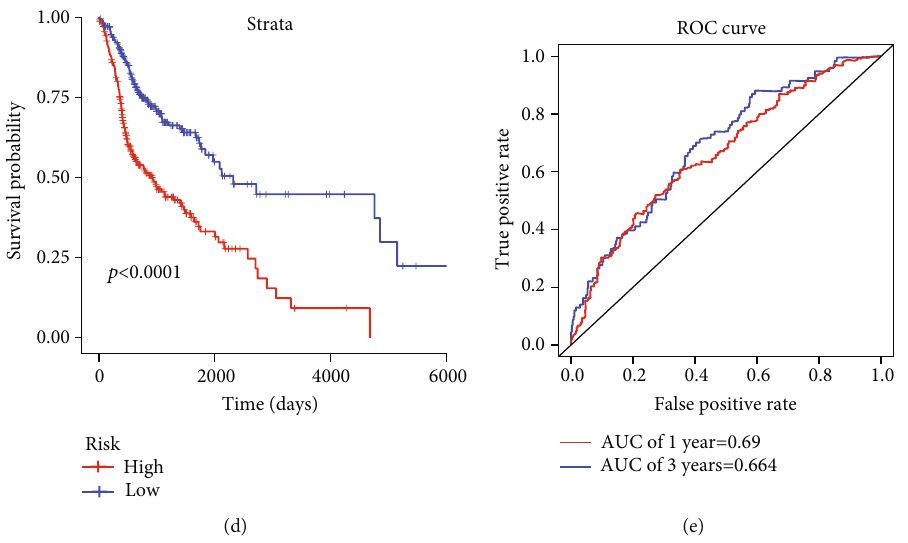
Figure 2: Establishment of a prognostic risk model for HNSCC. (a) Interaction network of highly related cell components. Analyzed by Spearman correlation analysis; j correlationindex j > 0 : 5 ; as edge color from yellow to purple, the correlation index increases. (b) Forest plot of 12 prognostic components. HR: hazard ratio; CI: con fi dence interval. (c) Heatmap showing di ff erential expression of 24 cell components that related to overall survival between the low- and high-risk group. (d) Kaplan – Meier plots of the prognostic model, with red line representing the high-risk group and blue line representing the low-risk group. (e) Receiver operating characteristic (ROC) curves for the low- and high-risk groups, with area under the curve (AUC)